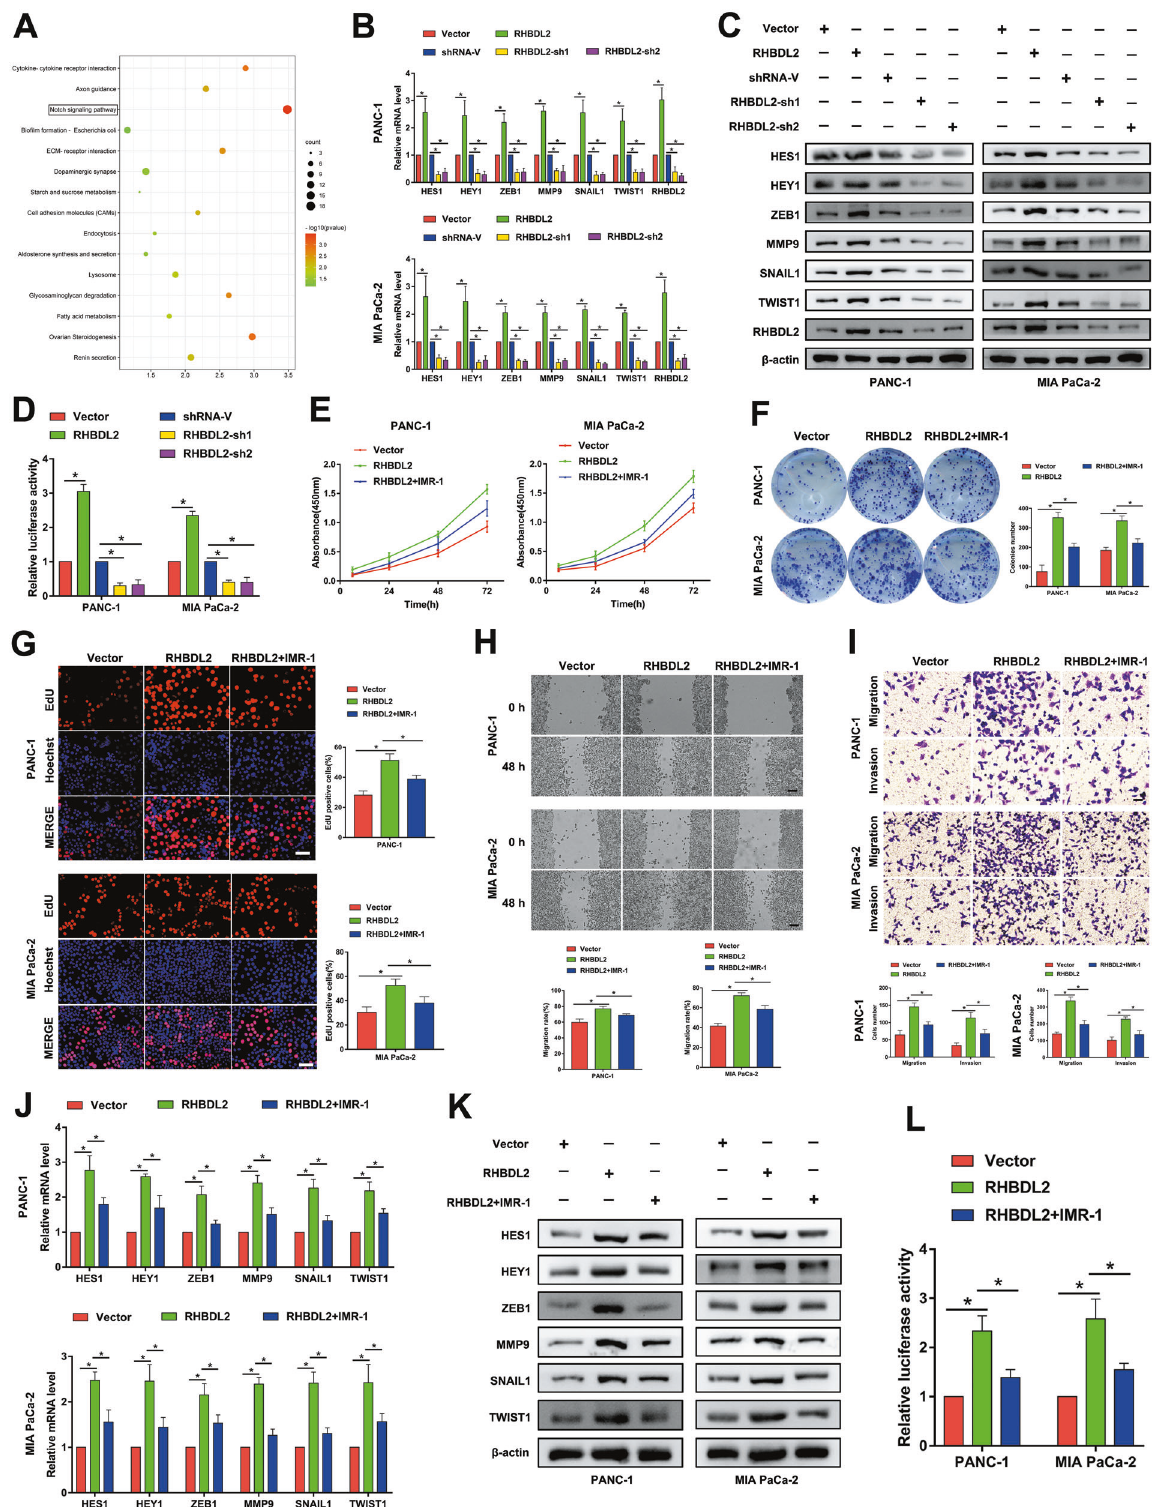
Fig. 3 RHBDL2 promotes proliferation and mobility of PC cells by activating the Notch signaling pathway. A The result of RNA-seq analysis. B , C qRT-PCR and Western blot analyses of RHBDL2, HES1, HEY1, ZEB1, MMP9, SNAIL1, and TWIST1 in the indicated PC cells. D Dual Luciferase Reporter Assay. CCK-8 ( E ), colony formation ( F ), and EdU (scale bar: 50 μ m) ( G ) assays of the PC cells incubated with/without IMR-1 (the inhibitor of Notch signaling pathway). Wound healing (scale bar: 100 μ m) ( H ) and Transwell (scale bar: 50 μ m) ( I ) assays of the indicated PC cells incubated with/without IMR-1. J , K qRT-PCR and Western blot analyses of HES1, HEY1, ZEB1, MMP9, SNAIL1, and TWIST1 in the indicated PC cells incubated with/without IMR-1. ( L ) Dual Luciferase Reporter Assay of the indicated PC cells incubated with/without IMR-1. * P < 0.05.